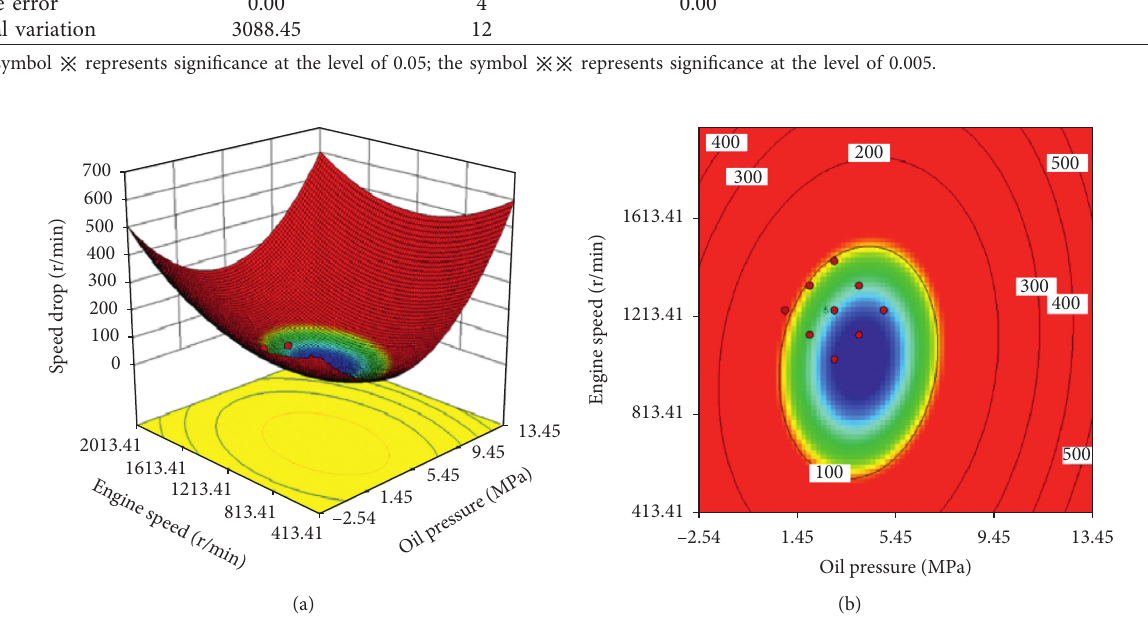
Figure 5: Response surface diagram and contour map of oil pressure and engine speed on interaction of speed drop. Table 7: Coefficient of regression equation and significance test for dynamic